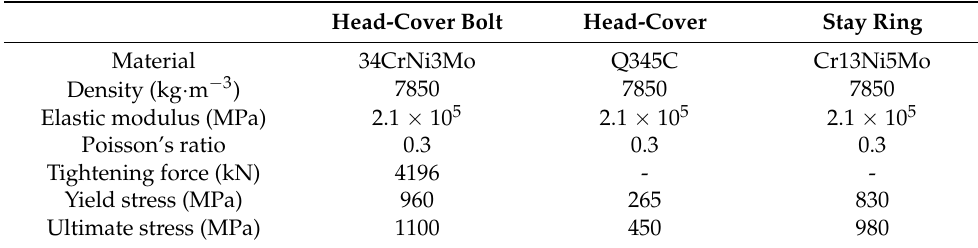
Table 2. Material and mechanical properties of the